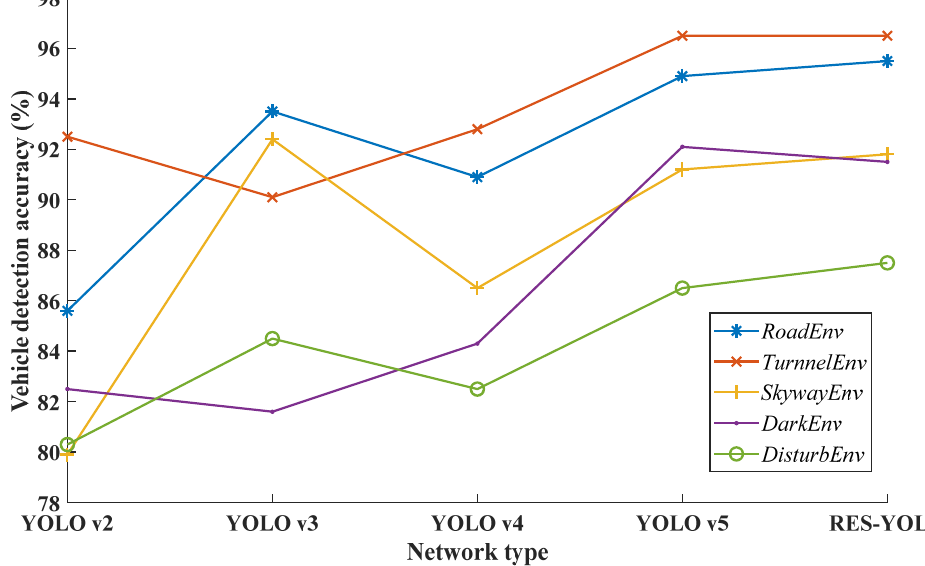
Figure 18. Actual test renderings of five types of networks.